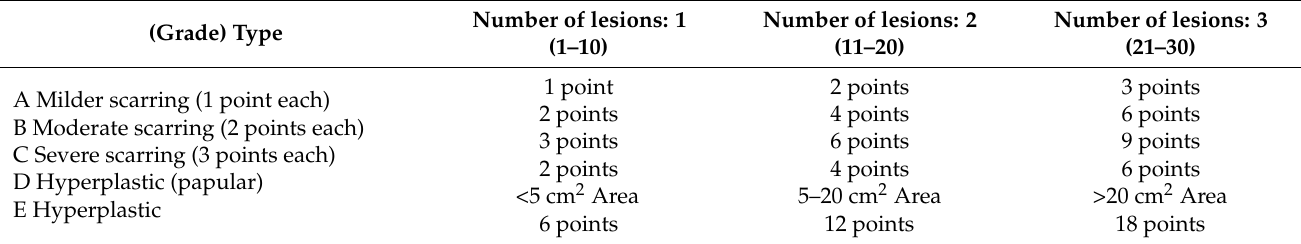
Table 1. Goodman and Baron’s quantitative grading scale.